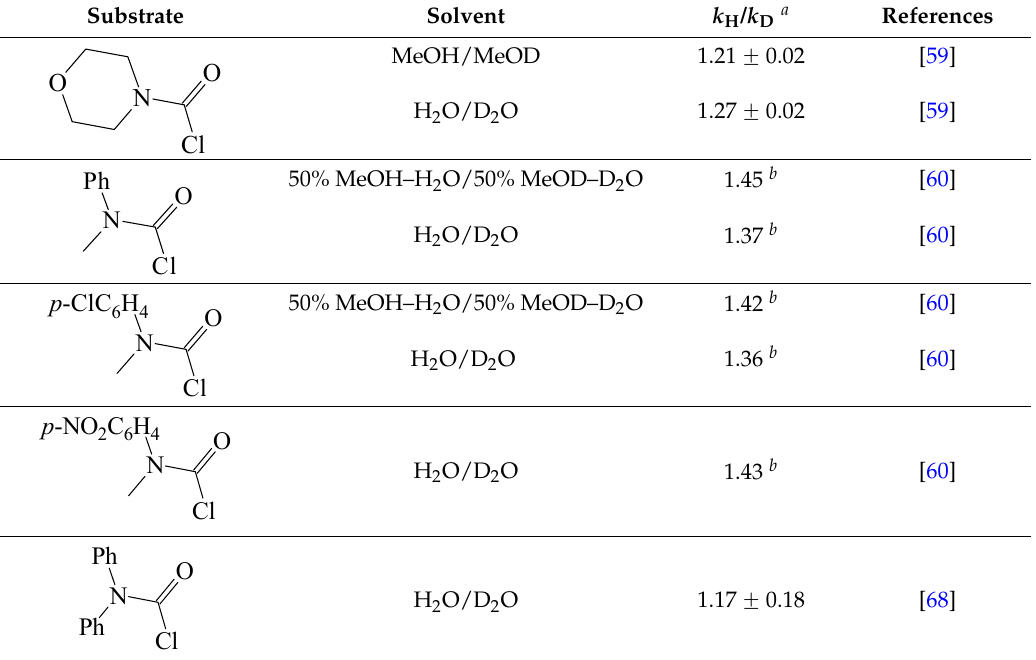
Table 3. Kinetic solvent isotope effect (KSIE) for solvolyses of five N , N -disubstituted carbamoyl chlorides at 25.0 °C.